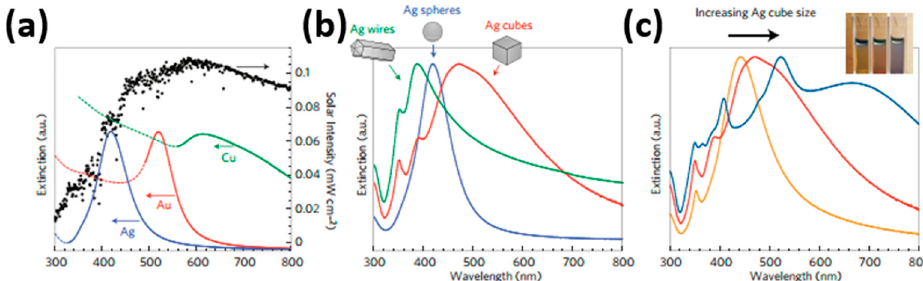
Figure 71. Finite difference time domain (FDTD) simulation of electric field intensity spatial distribution under 420 nm irradiation of ( a ) single 75 nm Ag nanocube; ( c ) two 75 nm Ag nanocubes separated by a distance of 1 nm (one cube is rotated 45°); ( b , d ) Electric field intensity enhancement as a function of distance along the dashed line in left figure respectively. Reproduced with permission from [122].